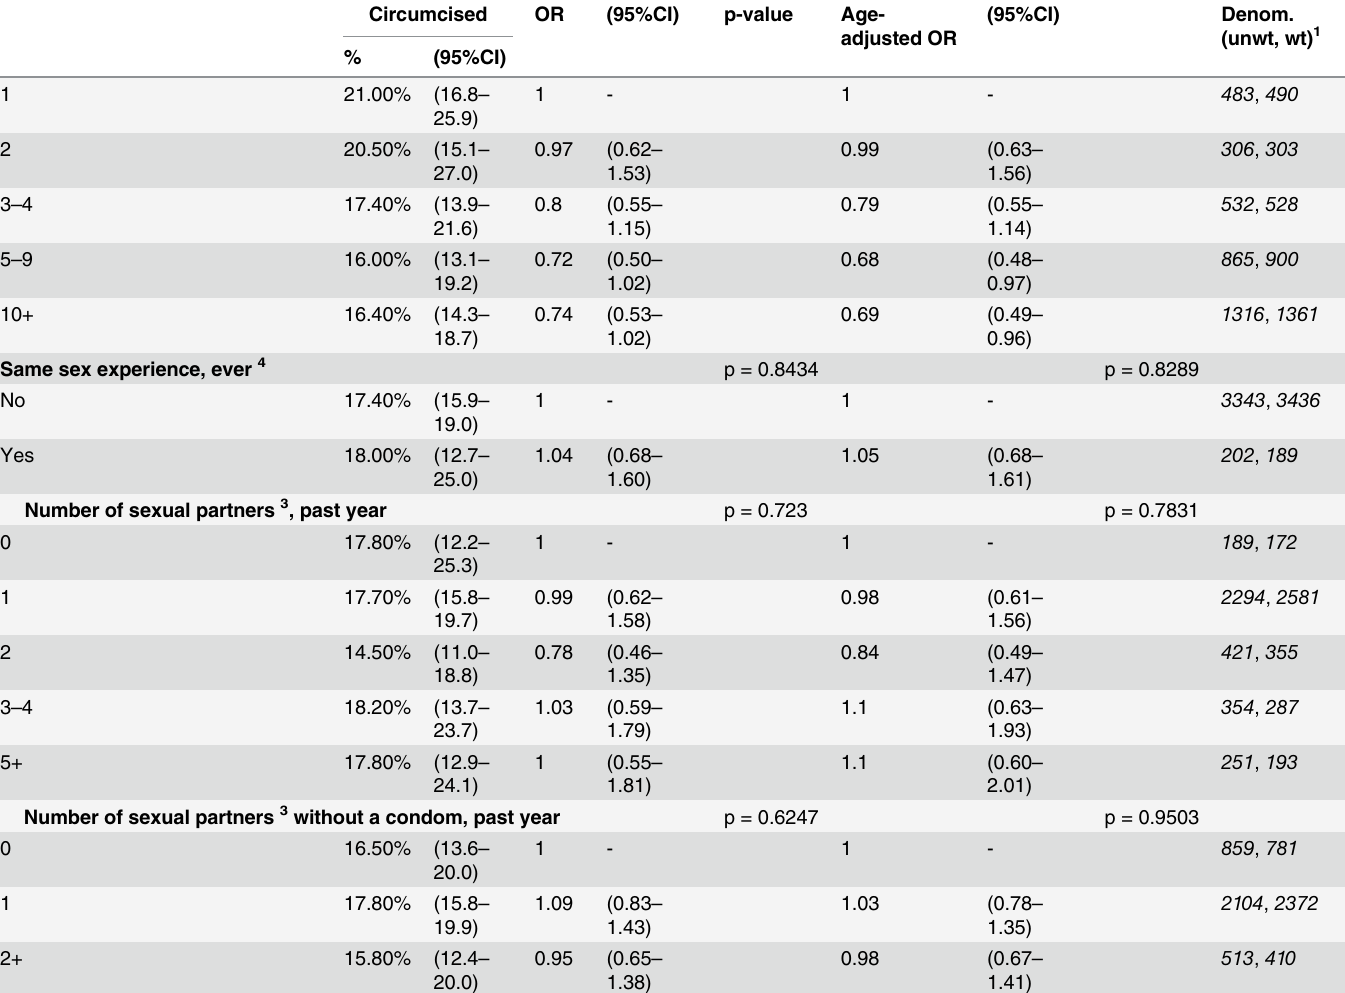
M . genitalium detected (Table 2). After adjusting for key demographic and behavioural